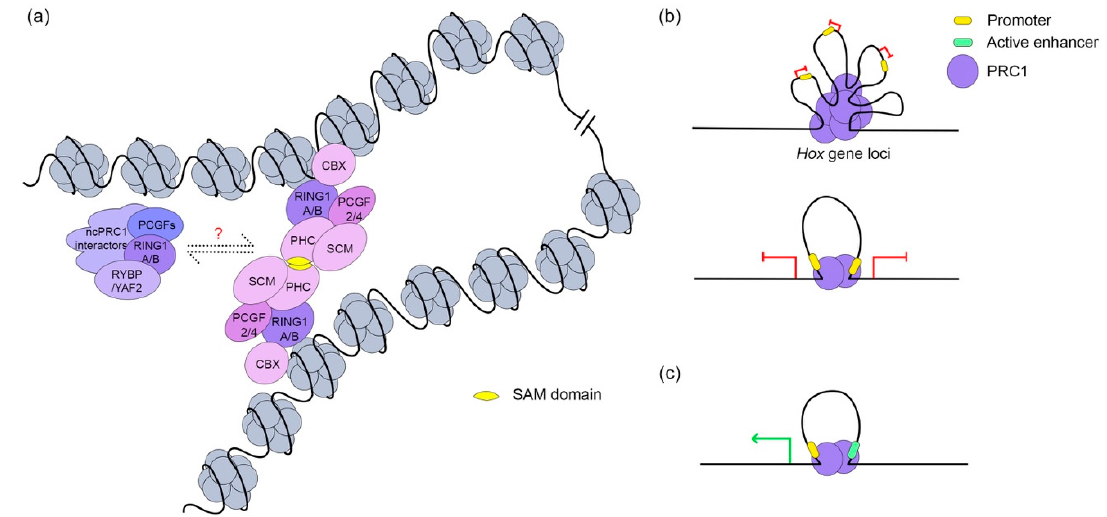
Figure 4. PRC1-mediated looping formation. ( a ) PRC1-mediated looping formation depends on the polymerization of PHC proteins’ sterile alpha motif (SAM) domain. It is unclear if ncPRC1 also is involved in long-range chromatin architecture regulation; ( b ) PRC1-mediated loops work in two patterns to repress anchored genes, either by chromatin compaction or co-occupied two promoters; ( c ) PRC1-mediated loop establishes contact between the promoter and active enhancer to activate anchored gene expression.